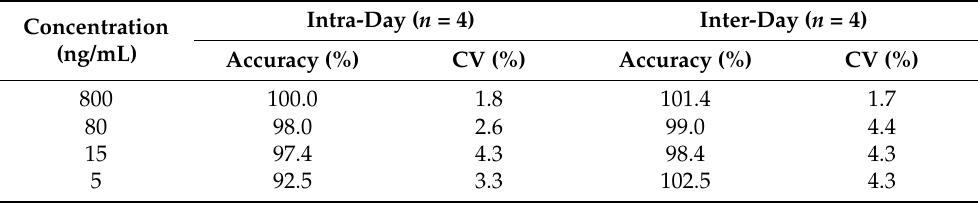
Table 1. Slopes, intercepts, and coe ffi cients of determination of calibration curves.